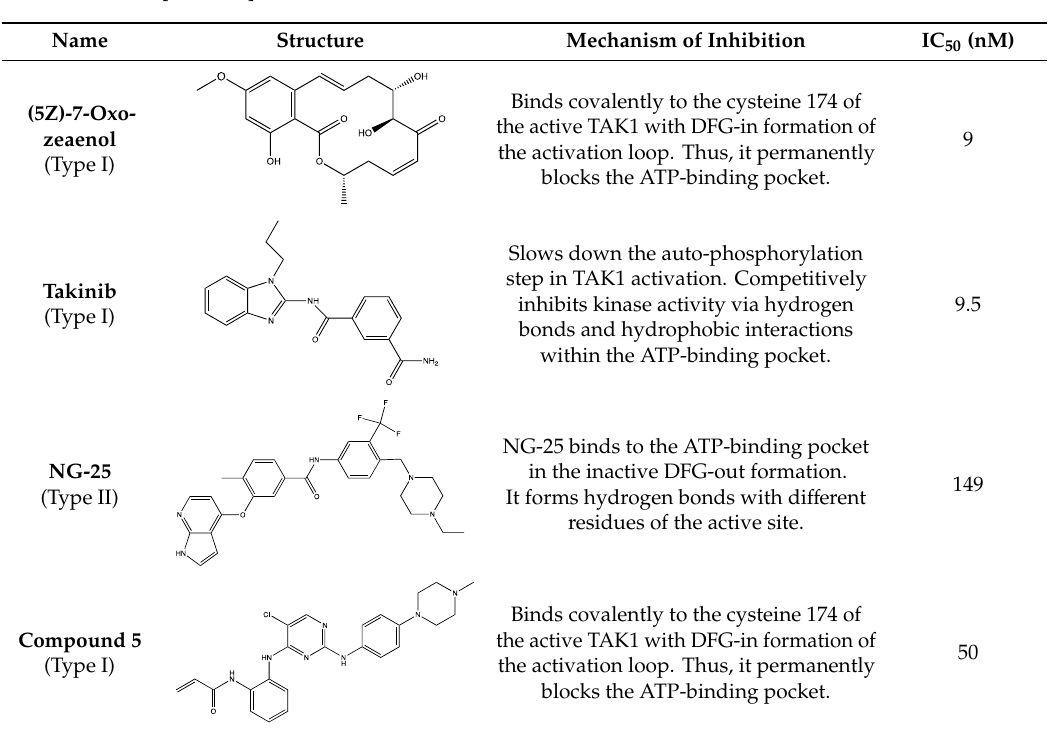
Table 1. Frequently used TAK1 inhibitors in experimental studies. IC 50 ‐ values depict the half maximal inhibitory concentrations and were determined using enzymatic assays as stated in the specific studies in References [104–107]. Structures were drawn with ChemDraw based on PubChem information.